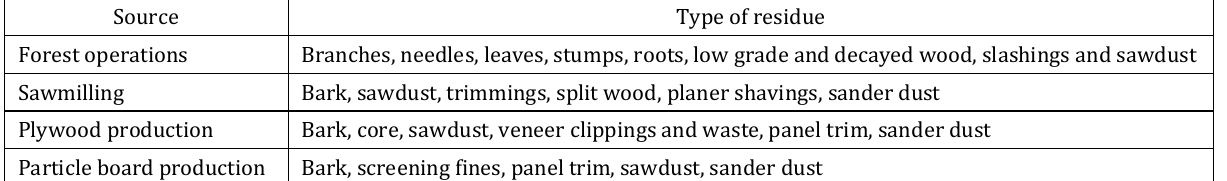
Table 1. Analysis of residues generated in wood processing (after Bowyer & Smith, 1998) Source Type of residue Forest